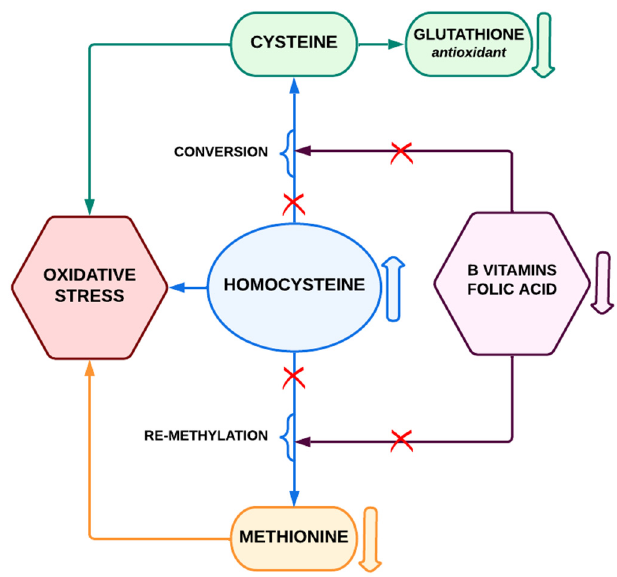
Figure 3. Methionine metabolic pathway (simplified)–pathway disorders in people with Down syn- drome.